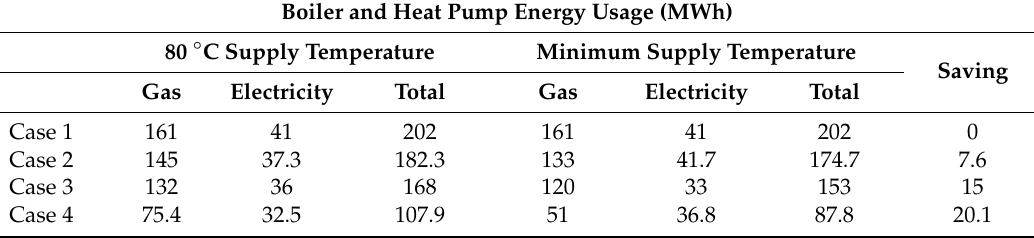
Table 7. Boiler and heat pump energy usage.